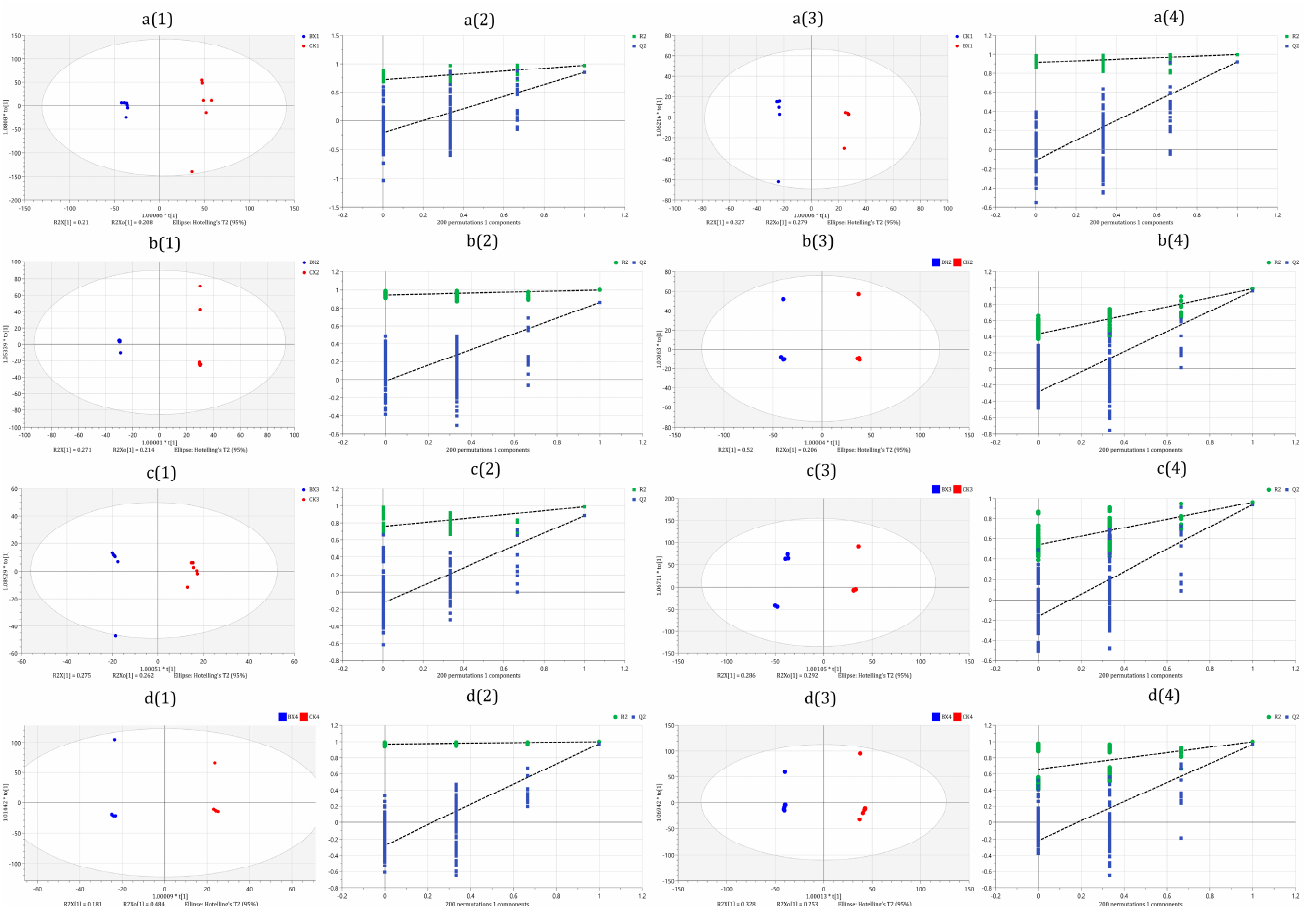
Figure 7. Orthogonal partial least-squares discriminant (OPLS-DA) analysis. a(1), b(1), c(1) , d(1) , a(3), b(3), c(3) and d(3) were score plot of OPLS-DA model; a(2), b(2), c(2) , d(2) , a(4), b(4), c(4) and b(3) , c(3) , d(3) ) were score plot of OPLS-DA model; ( a(2) , b(2) , c(2) , d(2) , a(4) , b(4) , c(4) , d(4) ) were overfit- d(4) were over fi tt ing analysis of the OPLS-DA model (two hundred permutations). ( a (1)-a (4)) bx1 ting analysis of the OPLS-DA model (two hundred permutations). ( a(1) – a(4) ) bx1 vs. ck1; ( b(1) – b(4) ) vs. ck1; ( b(1) – b(4) ) bx2 vs. ck2; ( c(1) – c(4) ) bx3 vs. ck3; ( d(1) – d(4) ) bx4 vs. ck4. bx2 vs. ck2; ( c(1) – c(4) ) bx3 vs. ck3; ( d(1) – d(4) ) bx4 vs.